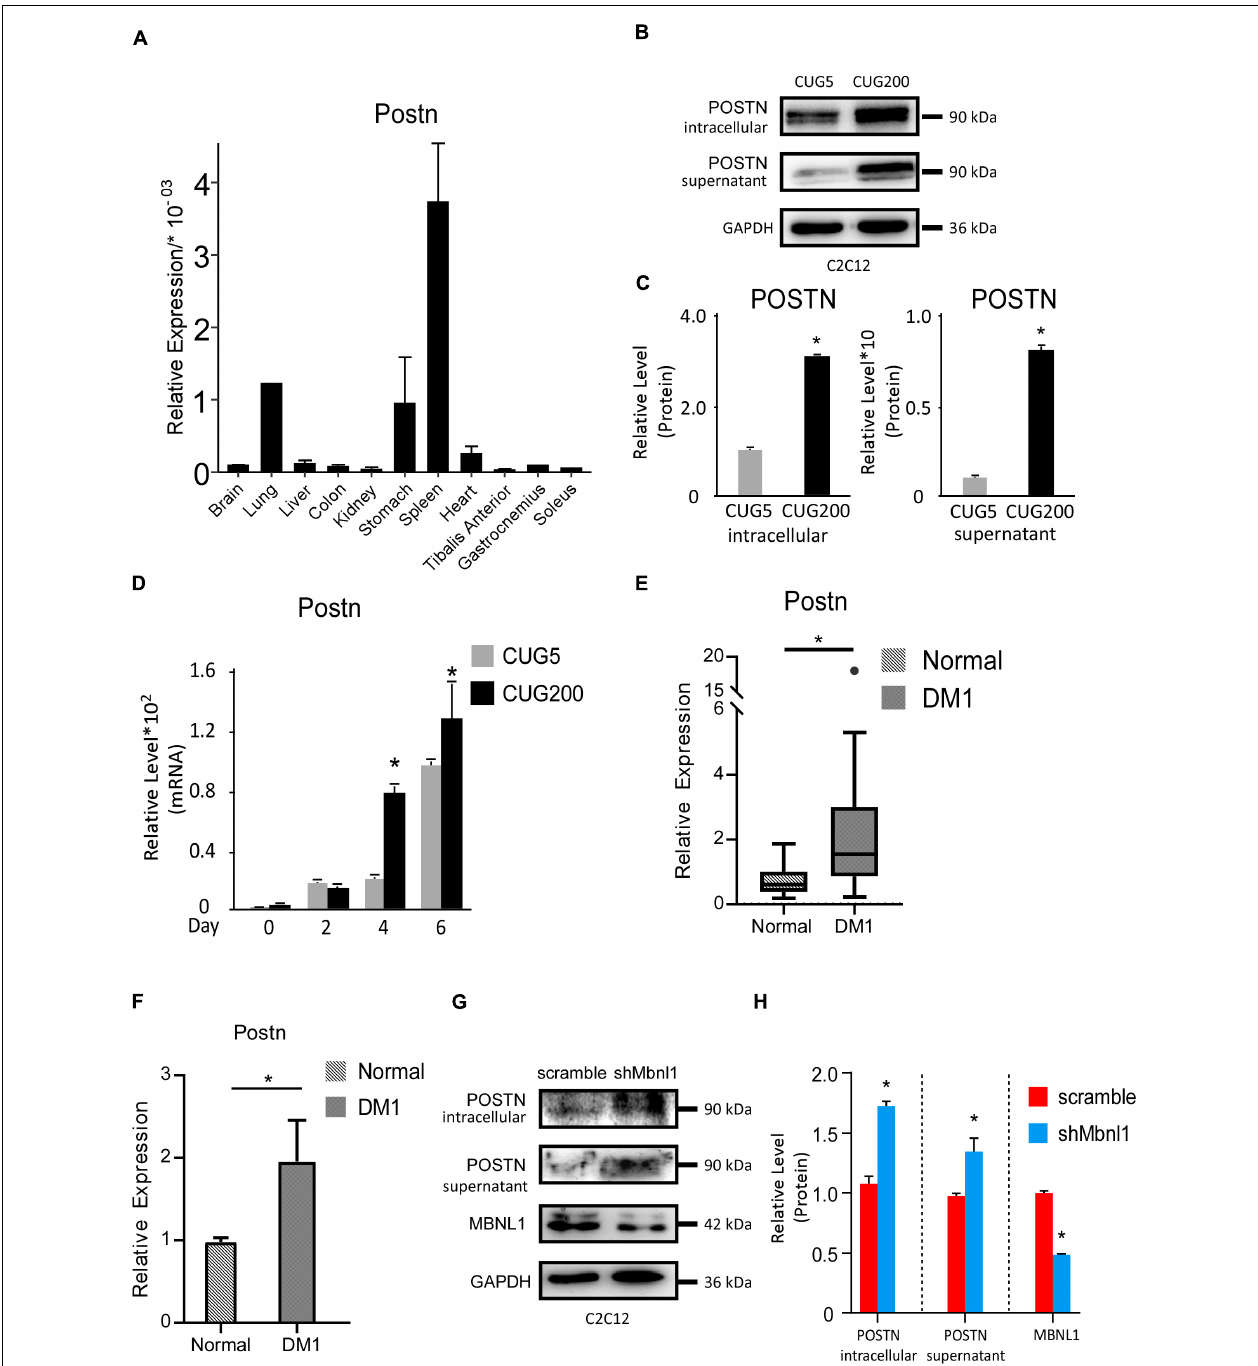
FIGURE 3 | Periostin was upregulated in DM1 myogenesis and in skeletal muscle of DM1 patients. (A) Expression levels of Postn in different tissues of normal adult mice, measured by RT-qPCR. (B) Intracellular and supernatant POSTN expression levels in normal and DM1 myoblast cells, detected by western blotting. (C) Gel band intensities from panel (B) quantified using ImageJ software. Values were normalized to GAPDH. (D) Expression levels of Postn during in vitro myoblast differentiation, measured by RT-qPCR. All expression levels were normalized to the values of the normal control at day 0. (E) Expression levels of Postn in tibialis anterior (TA) muscle from healthy individuals ( n = 10) and DM1 patients ( n = 40). (F) Expression levels of Postn in myoblasts from healthy individuals ( n = 3) and DM1 patients ( n = 3). (G) MBNL1, intracellular and supernatant POSTN expression levels in scramble control and Mbnl1 knockdown myoblast cells, detected by western blotting. (H) Gel band intensities from panel (G) quantified using ImageJ software. Values were normalized to GAPDH. CUG5, normal control myoblast cells (C2C12 GFP-CUG5); CUG200, DM1 myoblast cells (C2C12 GFP-CUG200); scramble, scramble control myoblast cells; and shMbnl1, Mbnl1 knockdown myoblast cells; * P <